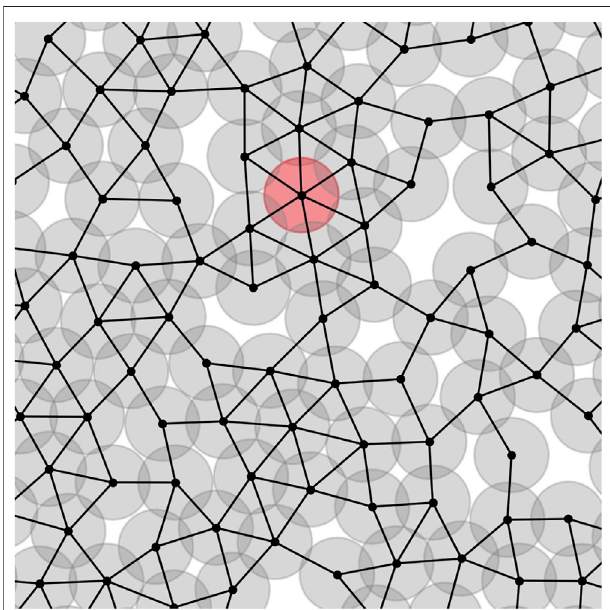
FIGURE 1 | Part of the network associated with a tumor. The center of cellsarethenetworknodes.Iftwocellsareincontact,alinkisformedbetween their centers. The red circle shows an instance cell with maximum number of neighbors, k max =